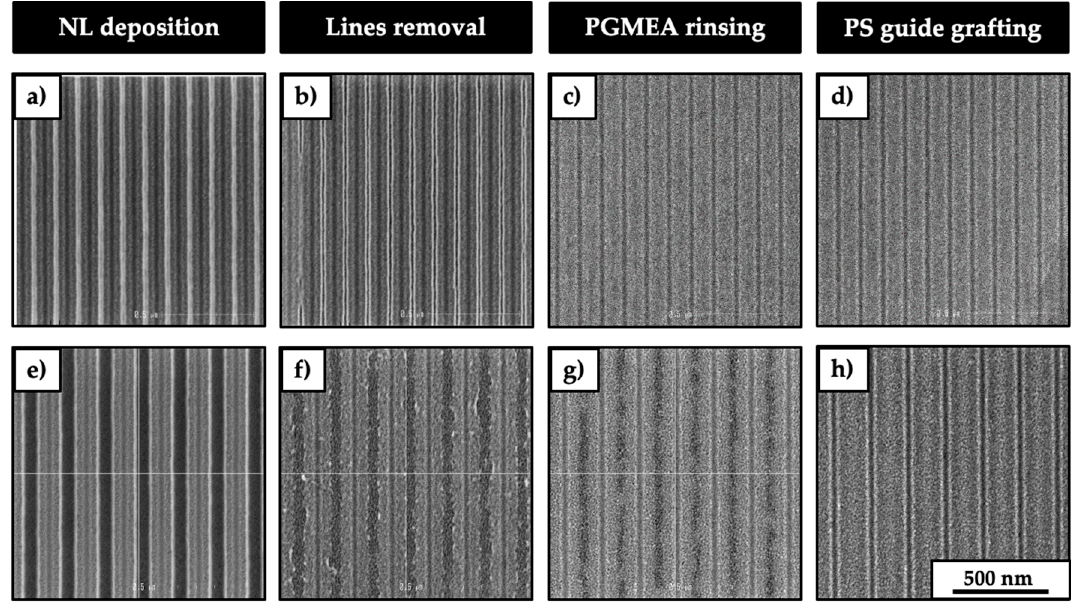
Figure 3. Representative plan view CD-SEM images of the steps: NLa deposition ( a ), NLb, NLc, NLd ( e ), lines removal with HF ( b , f ), PGMEA rinsing ( c , g ), and PS guide grafting ( d , h ).